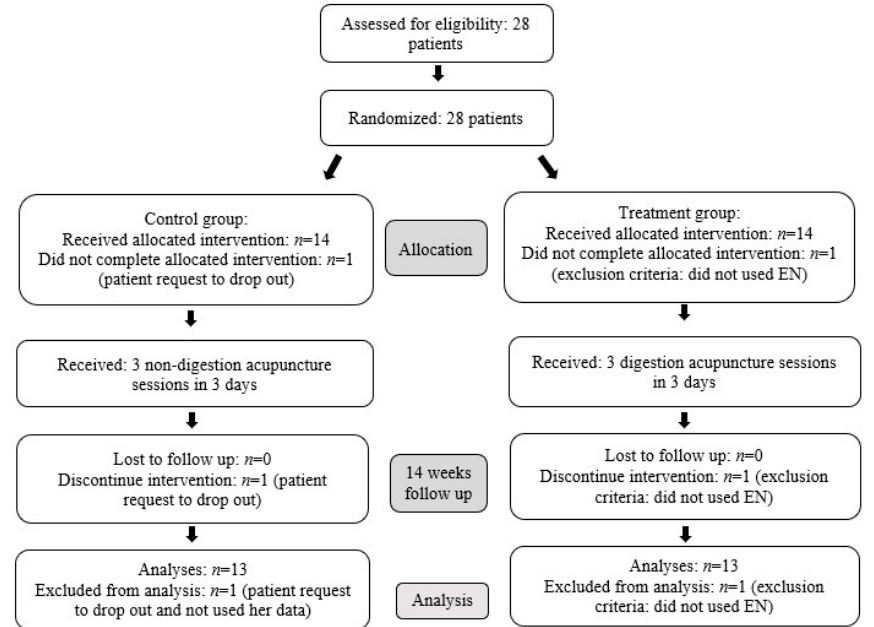
Figure 1. Recruitment and participant flow chart depicting information regarding enrolment, interventions, and analytic processes. Post randomization, one patient was excluded from each group and not analyzed. Table 1. Baseline characteristics.